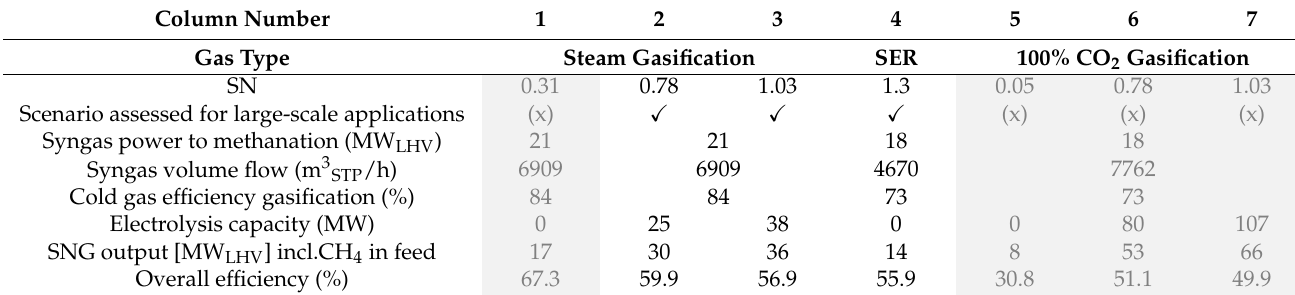
Syngas power to methanation (MW LHV